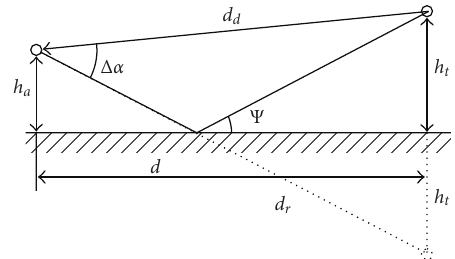
Figure 1: Multipath problem for an antenna (left) and a target (right) above a flat sea surface.